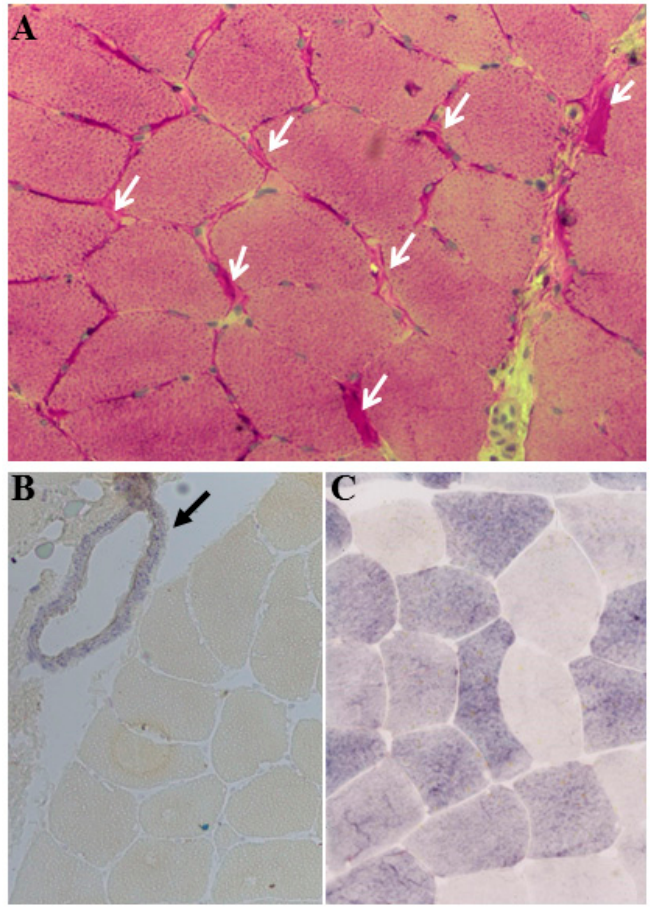
Figure 2. Myohistological and histochemical features of the muscle biopsy (200× magnification) of a patient with p.Arg50Ter mutation in homozygous state showing ( A ) subsarcolemmal glycogen accumulation (white arrows), ( B ) complete loss of myophosphorylase activity in patient’s muscle biopsy (although phosphorylase on the smooth muscle cells of blood vessel is stained; shown by an arrow) in comparison to ( C ) positive myophosphorylase reaction in muscle biopsy of healthy control.